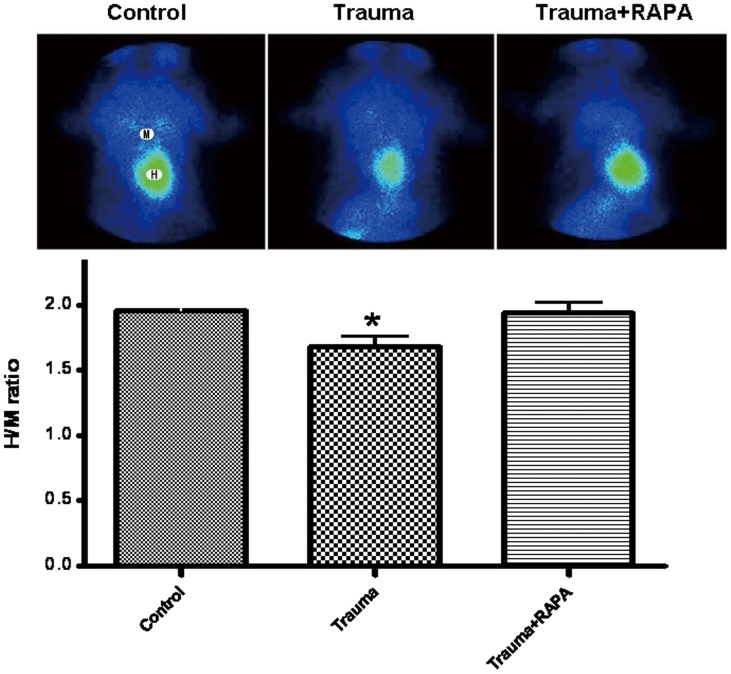
Cardiac radionuclide imaging gained from rats which reflected mitochondrial function.Anterior planar images were obtained 30 min after Technetium 99 m sestamibi (99 mTc-MIBI) intravenous injection. Cardiac 99 mTc-MIBI uptake was expressed as H/M ratio which was obtained using regions of interest positioned over the heart (H) and upper mediastinum (M). Nonlethal mechanical trauma resulted in significant decrease in uptake of 99 mTc-MIBI, which was prevented by administration of rapamycin (RAPA) 30 min before trauma. Data are expressed as Mean ± SD (n = 6). * p<0.05.